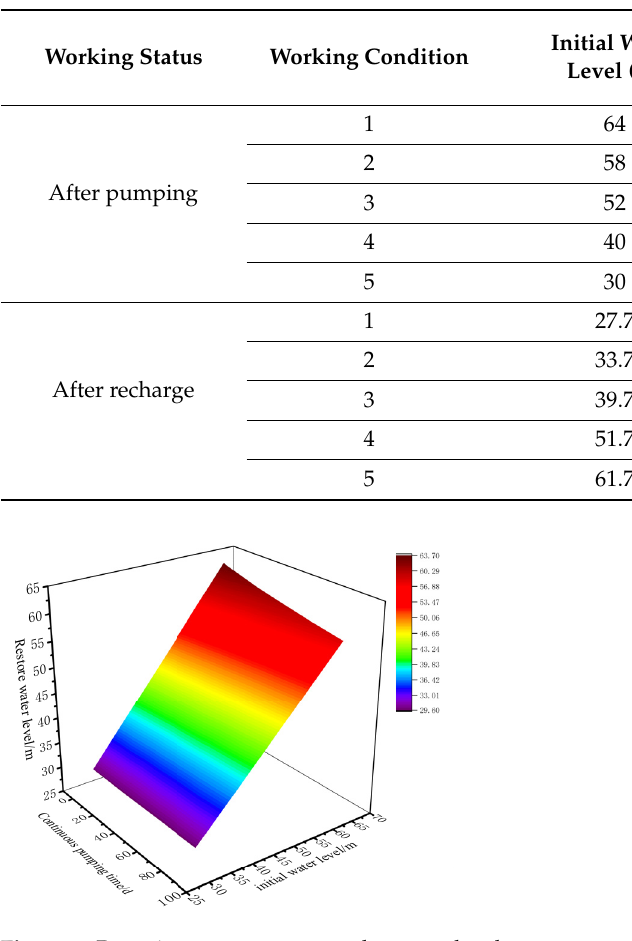
Figure 7. Pumping water to restore the water level.